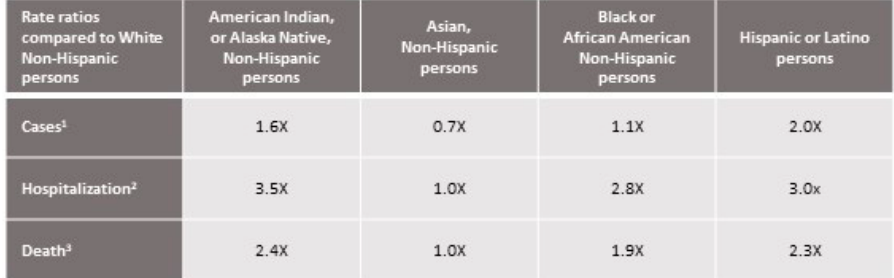
Figure 3. Risk for COVID-19 infection, hospitalization, and death by race/ethnicity [72]. 1 Data Source: Data reported by state and territorial jurisdictions (accessed 11 April 2021). Numbers are ratios of age-adjusted rates standardized to the 2019 U.S. intercensal population estimate. Calculations used only the 61% of case reports that have race and ethnicity data available; this can result in inaccurate estimates of the relative risk among groups. 2 Data Source: COVID-NET (https://www.cdc.gov/coronavirus/2019-ncov/covid-data/covid-net/purpose-methods.html, accessed 1 March 2020, through 3 April 2021). Numbers are ratios of age-adjusted rates standardized to the 2019 US standard COVID-NET catchment population. 3 Data Source: National Center for Health Statistics (NCHS) provisional death counts (https://data.cdc.gov/NCHS/Provisional-Death-Counts-for-Coronavirus-Disease-C/pj7m-y5uh, data through 3 April 2021). Numbers are ratios of age-adjusted rates standardized to the 2019 US intercensal population estimate. Reproduced with permission from the U.S. Center for Disease Control (accessed 18 April 2021) [72].